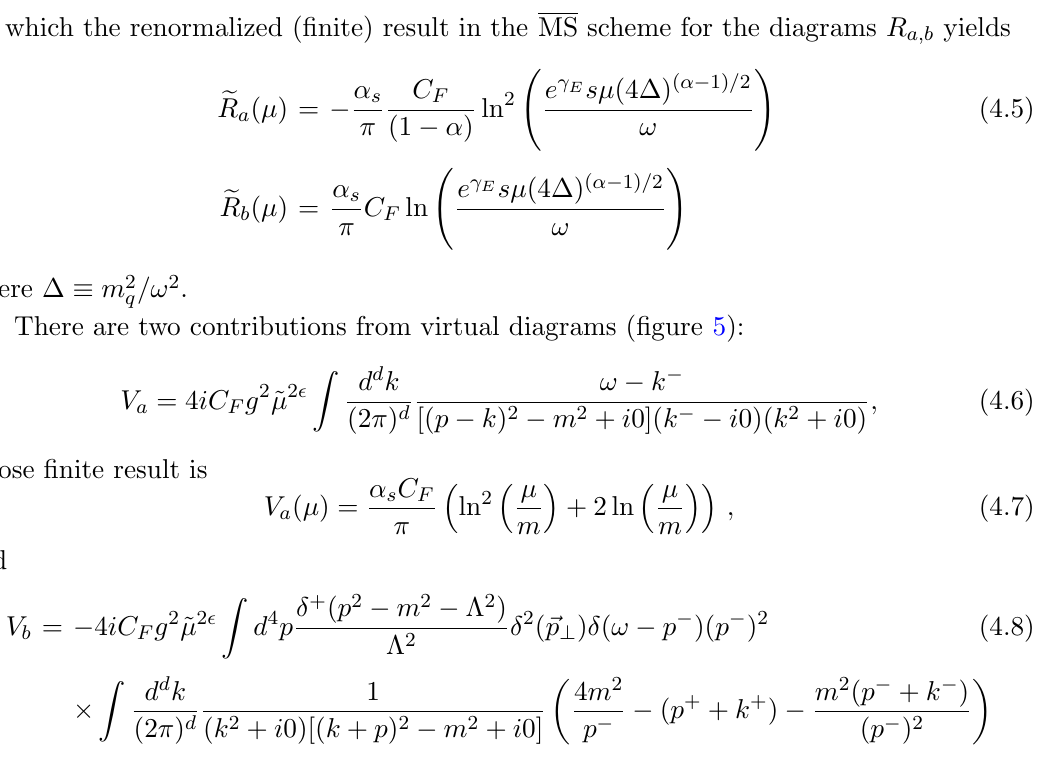
Figure 5 . Real and virtual diagrams contributing to the jet